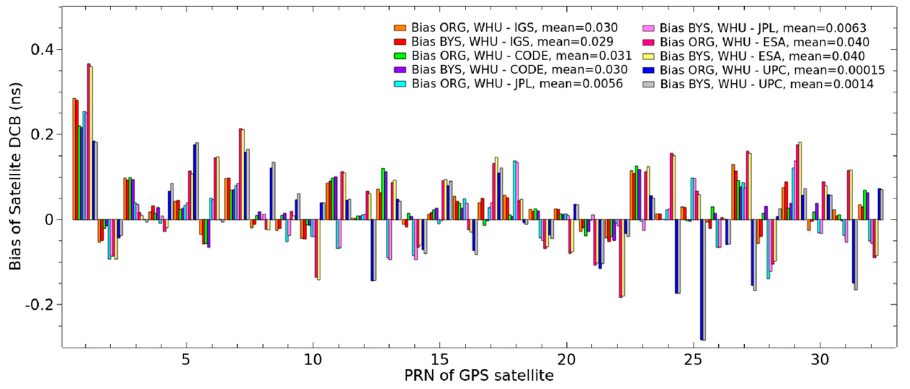
Figure 9. Biases of satellites DCBs from the comparisons between WHU products based on original LSE or Bayesian estimation and the IGS final combined products or IAAC products.